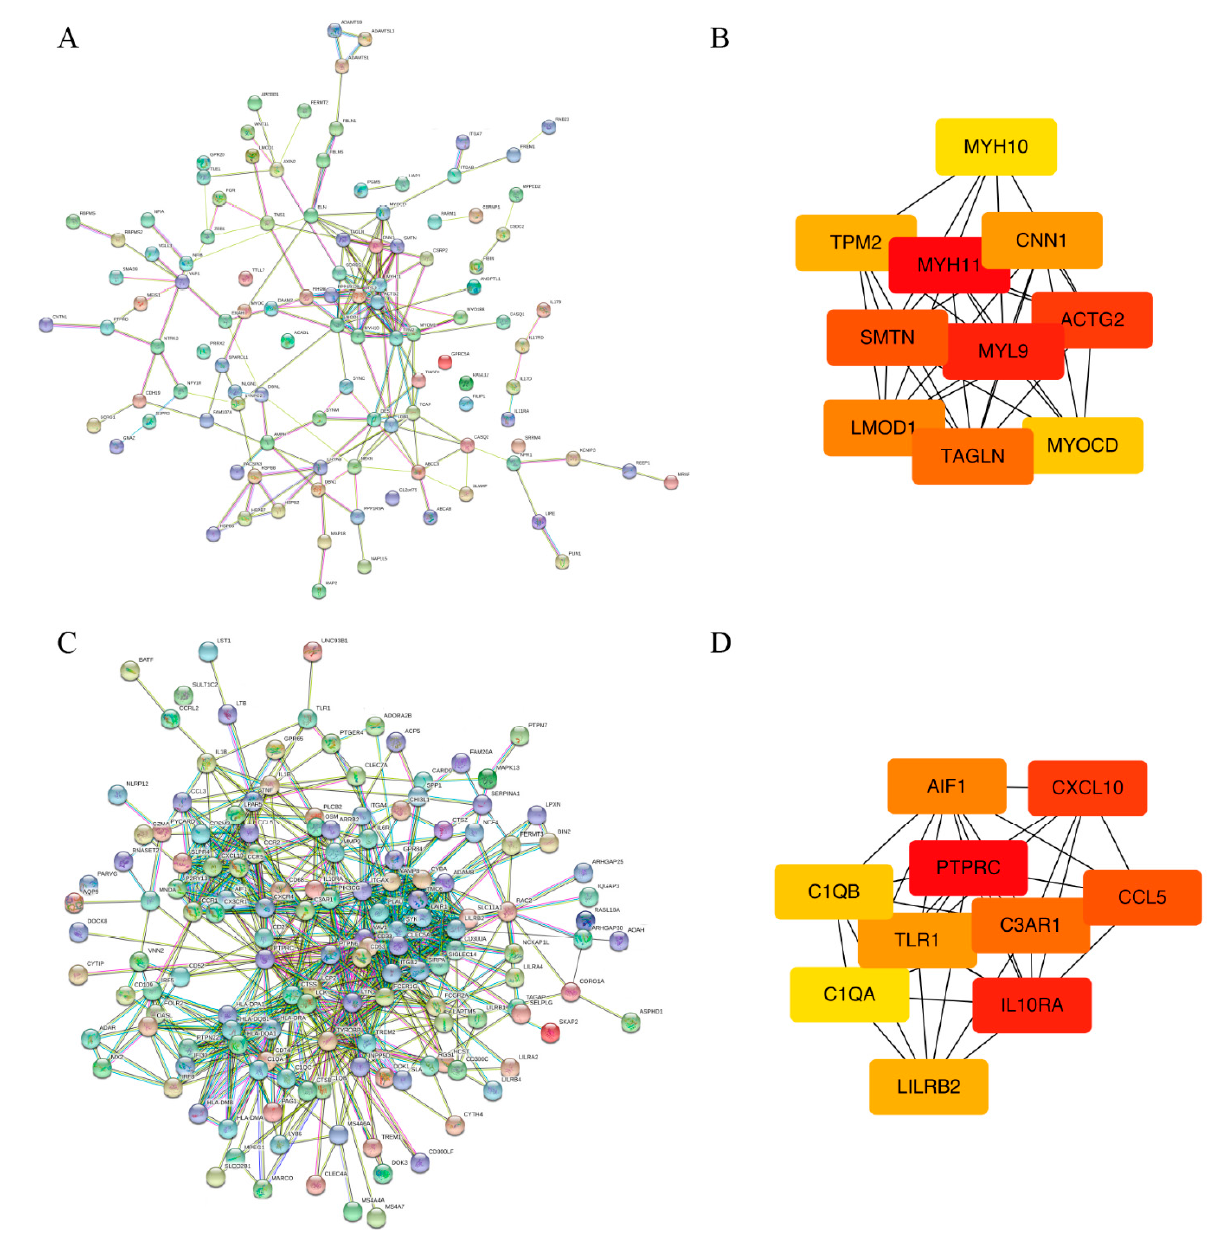
Figure 10. PPI network analysis and hub gene selection of hyper-down genes and hypo-up genes in AS using gene expression dataset (GSE100927) and DNA methylation dataset (GSE46401). The top 10 hyper-down/hypo-up genes with the highest degree of connectivity were determined as hub genes, which were selected using the Maximal Clique Centrality (MCC) method through the Cyto- Hubba plugin of Cytoscape. ( A ) The protein–protein interaction (PPI) network of hyper-down genes. ( B ) The hub genes of hyper-down genes. ( C ) The PPI network of hypo-up genes. ( D ) The hub genes of hypo-up genes. Hyper-down genes represent hypermethylated and downregulated genes. Hypo-up genes represent hypomethylated and upregulated genes. Line color indicates the type of interaction evidence; blue lines represent gene co-occurrence, black lines represent co-expression, and pink lines represent experiment determined relations. PPI enrichment p -value < 1.0 × 10 − 16 .